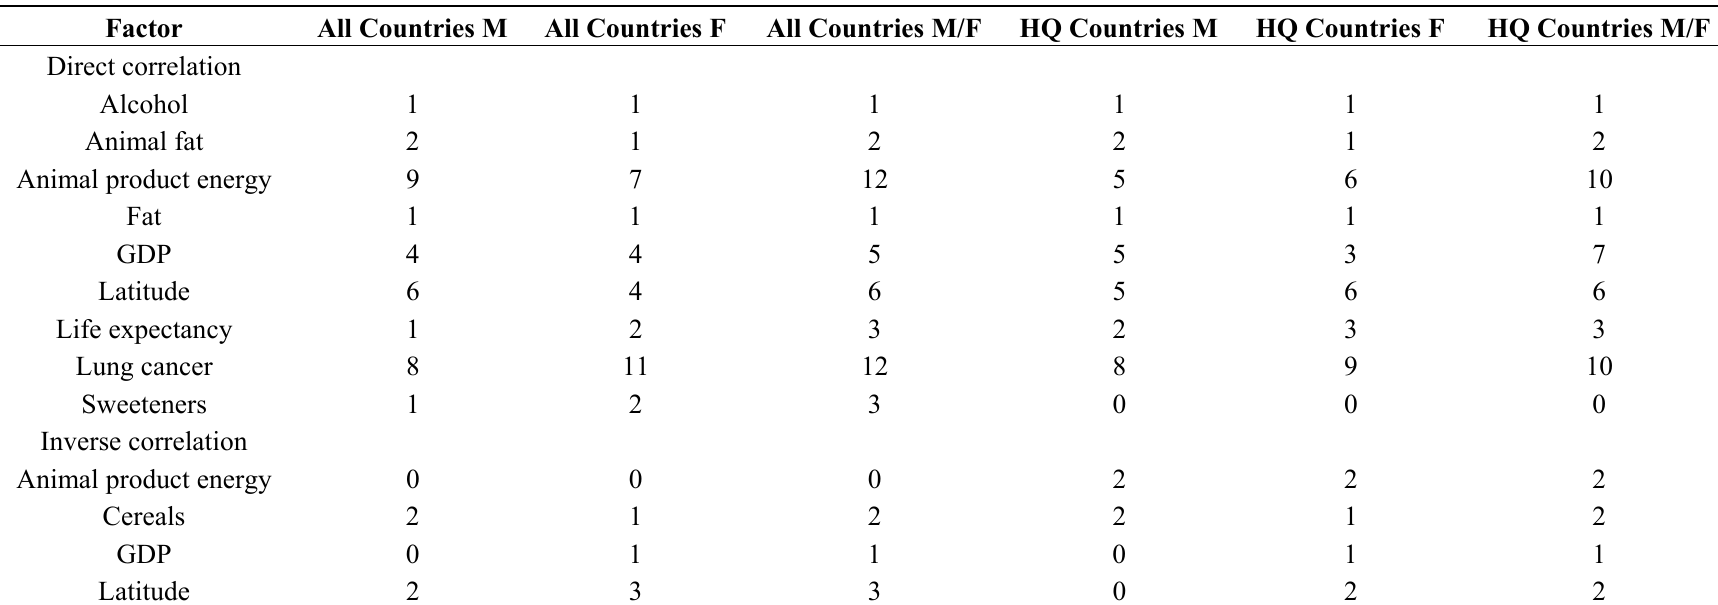
Table 4. Numbers of cancer types for which significant direct and inverse correlations were